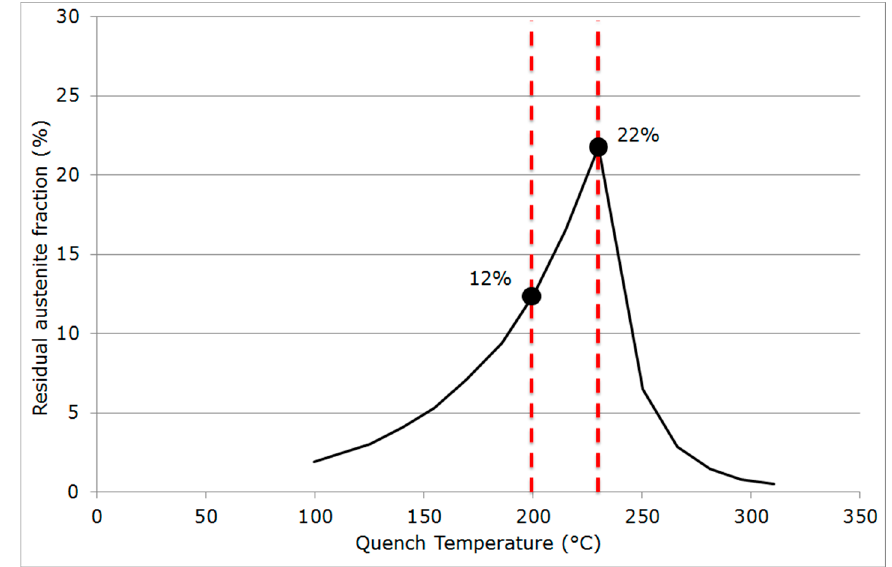
Figure 2. Retained austenite at room temperature (RT) after Q&P as a function of QT in the studied steel according to the classical approach of Speer at al. (Carbon Constraint Equilibrium (CCE) assumption and model of Van Bohemen et al. for martensitic transformation kinetics) [4–6,25,26]. The dashed lines represent both QTs addressed in the present study.